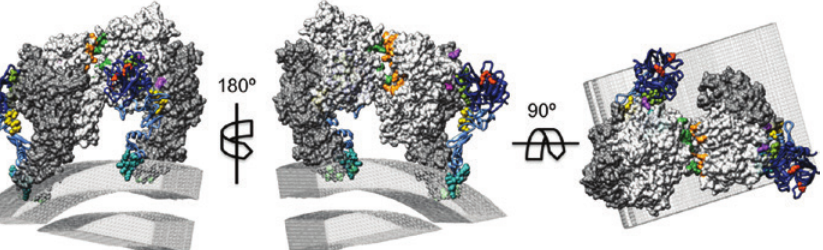
Figure 4: Assembly of the tenase complex. The membrane-bound FVIII heterodimer is shown as a surface based on the fitting of the FVIII- LNT (Figure 3) within the CryoEM density resolved for the helically organized FVIII-BDD on LNT [11]. The density of the LNT bilayer resolved by CryoEM is shown as a gray mesh. From left to right are shown orthogonal views of the membrane-bound FVIII dimer – perpendicular and along the LNT surface. The FVIII light chain is shown as a dark gray surface and the heavy chain as a light gray surface. The residues at the FVIII monomer-monomer interface at a distance less than 8.7 Å are colored green and orange, respectively. The C2 domain-membrane-binding residues are shown as a light green surface. The A2 and A3 domain residues identified to bind to the FIXa are shown as magenta spheres. The FIXa molecules-PDB:1PFX [103] are shown as ribbons. The FIXa heavy chain (protease domain) is colored in dark blue, and the light chain holding the two EGF-like domains and the membrane-binding Gla domain is shown in cyan. The Asp39, His57, and Cys195 residues forming the FIXa proteolytic (active) site are shown as red spheres. The identified primary and secondary FIXa binding sites for FVIIIa are shown with green and yellow spheres, respectively. The residues from the membrane-binding FIXa-Gla domain are shown as cyan